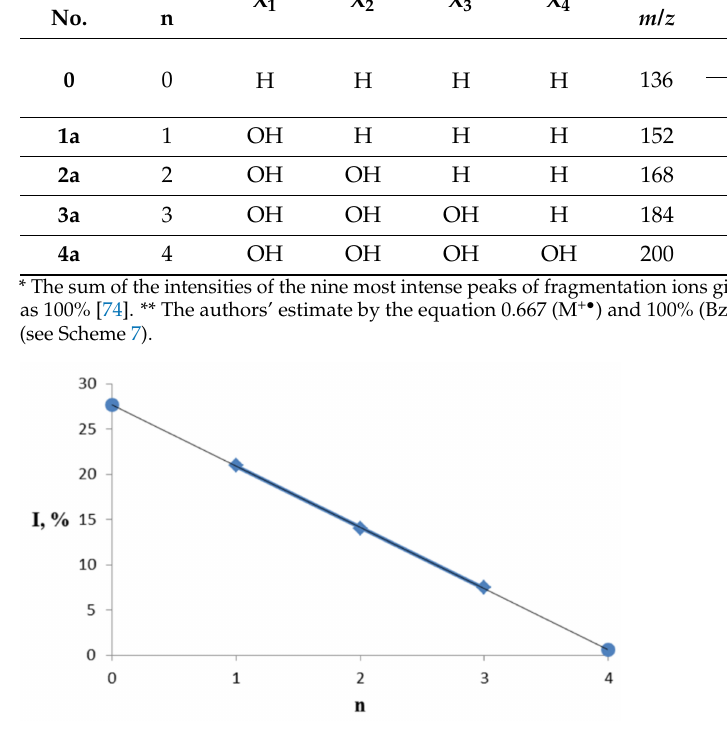
Figure 9. Correlation of the relative intensity I of the molecular ion Ad(OH) n+ • and the number n = 0–4 of hydroxyl groups introduced into the tertiary positions of 0 : experimental data for n = 1–3 and the authors’ estimates for n = 0,